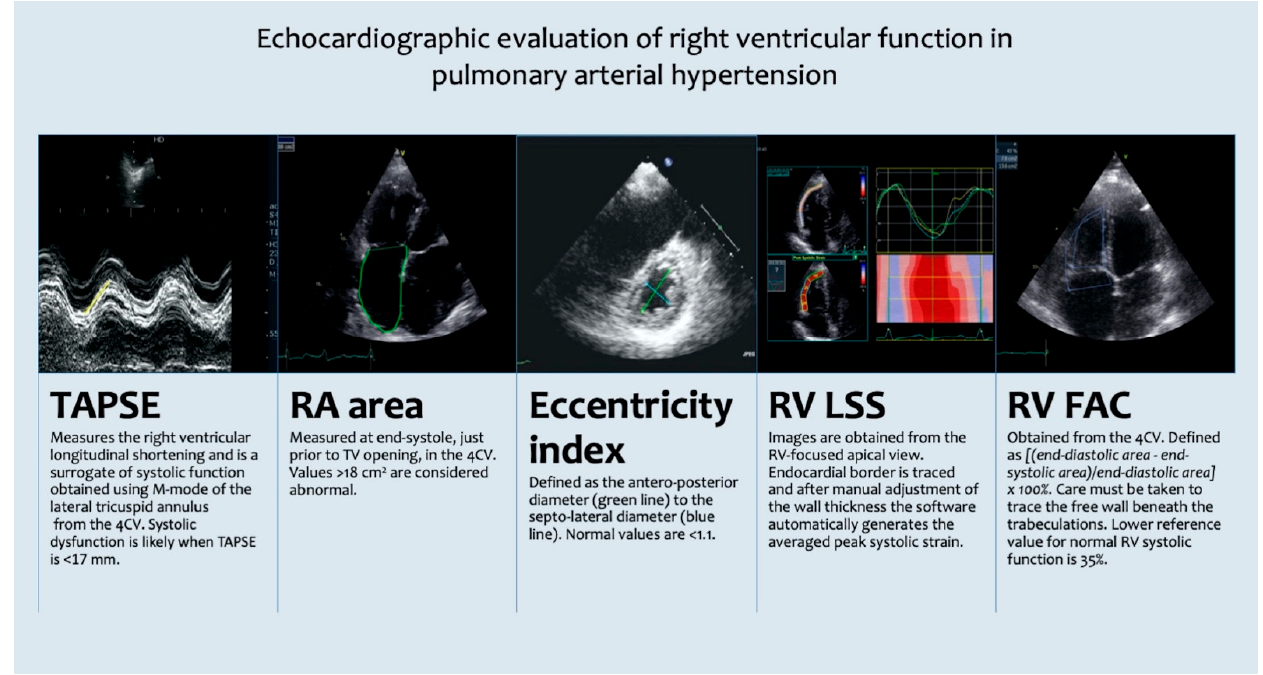
Figure 1. Echocardiographic evaluation of right ventricular function in pulmonary arterial hypertension. 4CV: four-chamber view; FAC: fractional area change; LSS: longitudinal free-wall strain; RA: right atrium; RV: right ventricular; TAPSE: tricuspid annular plane systolic excursion.